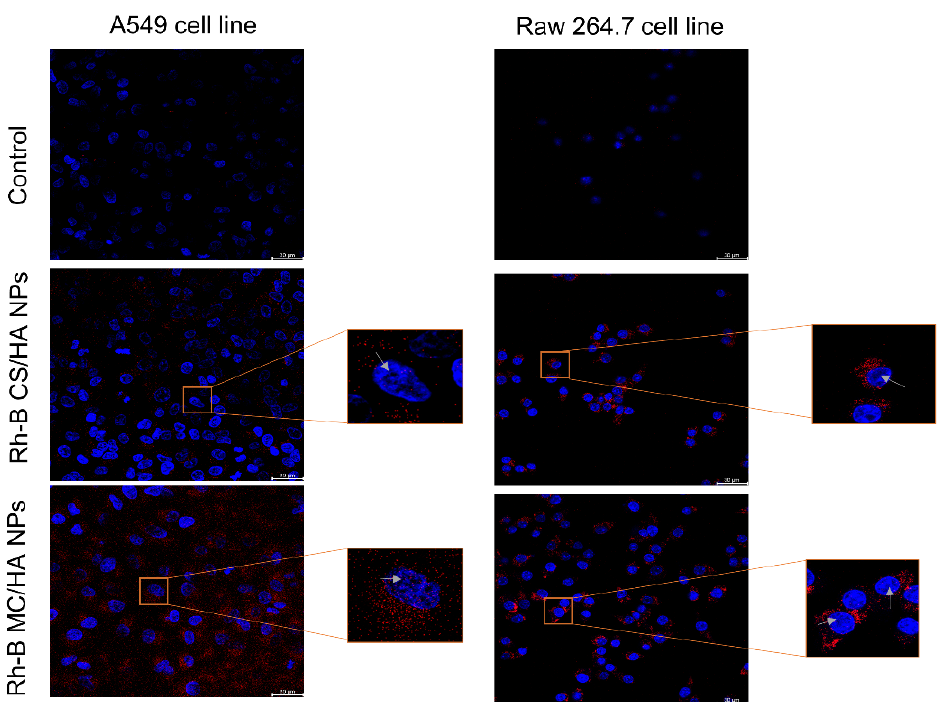
Figure 7. Cellular internalization study via confocal imaging. Confocal images of A549 cells and Raw 264.7 macrophages showing the internalization of Rhodamine-B labeled NPs (red) after an incubation of 2 h. The blue color indicates the nuclei staining with DAPI-dye. Rhodamine-B (Excitation λ max = 546 nm, Emission λ max = 568 nm), DAPI-dye (Excitation λ max = 359 nm, Emission λ max = 457 nm).